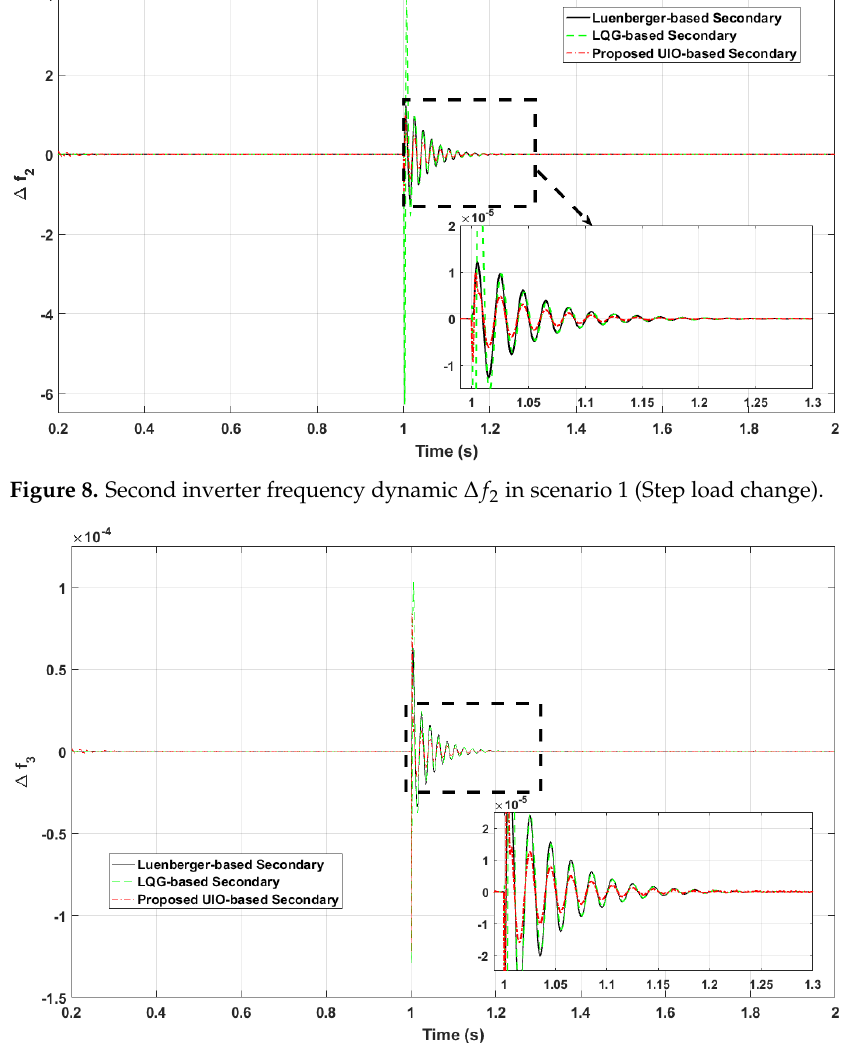
Figure 9. Third inverter frequency dynamic ∆ f 3 in scenario 1 (Step load